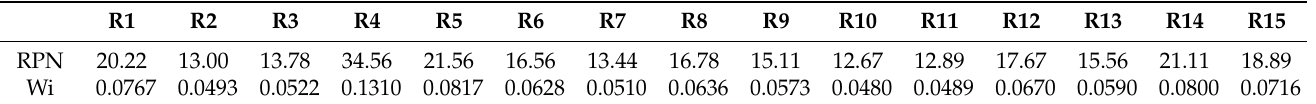
Table 11. Relative weights of RPNs after normalization.